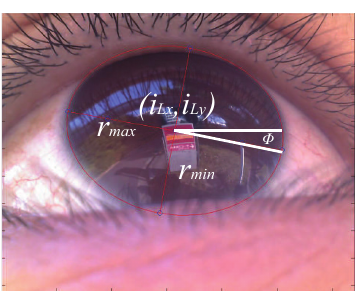
Figure 4 . The iris area is extracted using an ellipse and it is indi- cated in red.